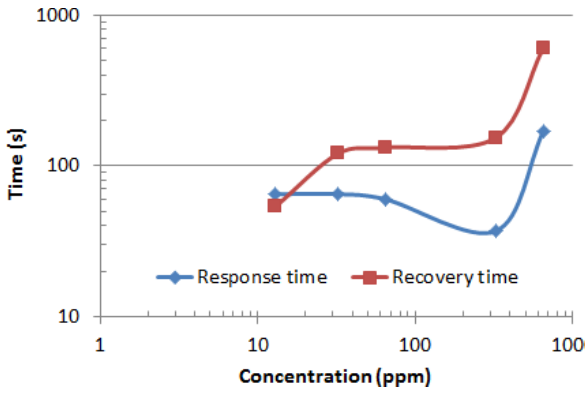
Figure 8. Dependence of the response of MWCNTs/SnO 2 FA va- por sensor on gas concentration measured at 200 ◦ C operating tem- perature.